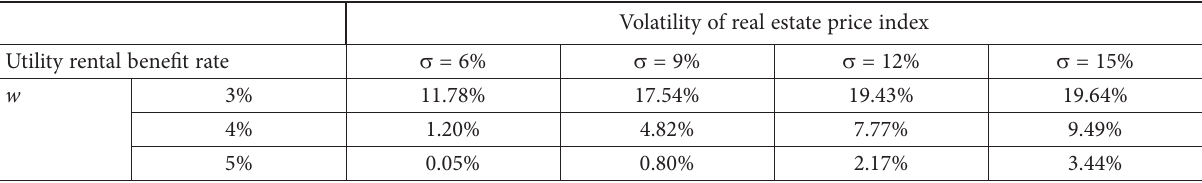
Table 4. Probability for homeowners to sell houses across the volatility of the real estate price index and utility rental benefit rate